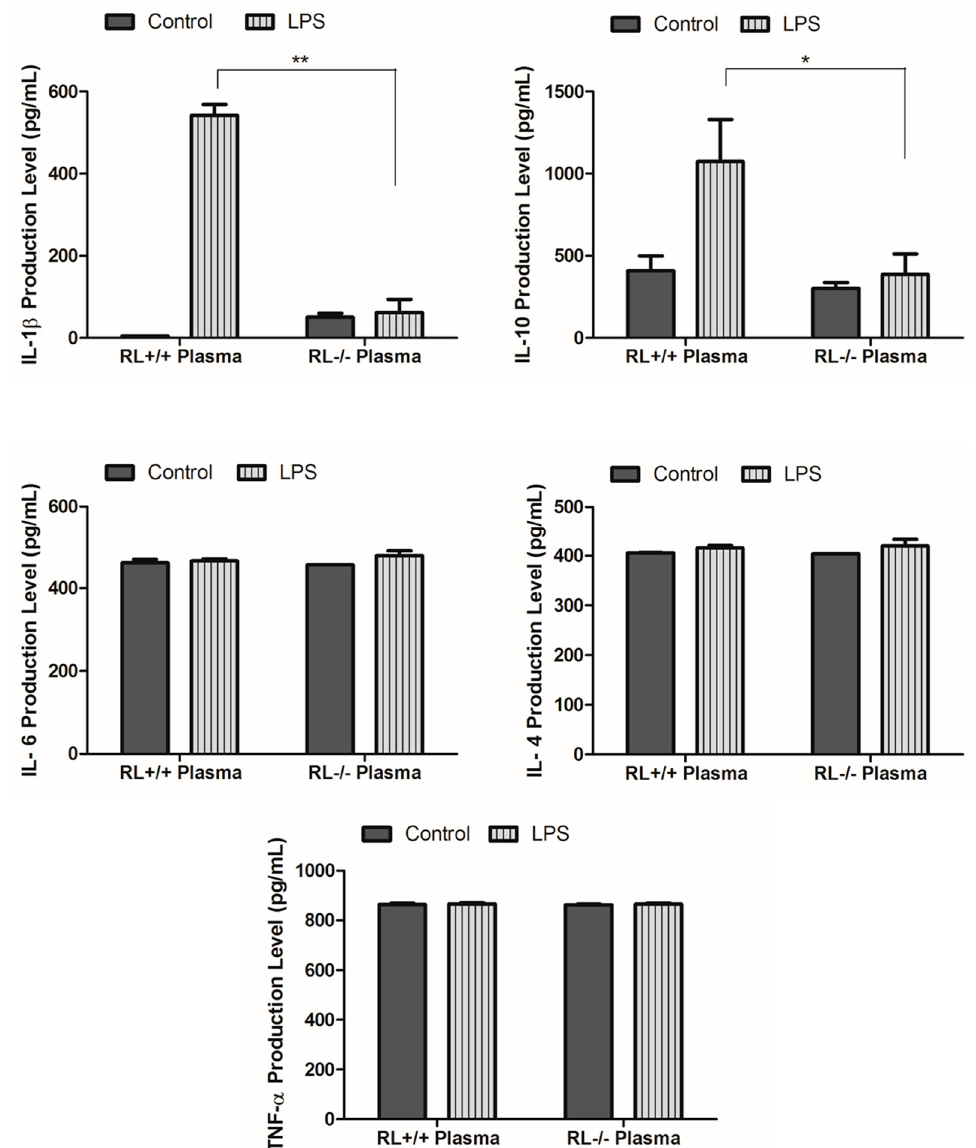
Figure 3. Levels of certain cytokines and chemokines in the plasma. Cornea blood was isolated from RNase L wild type and deficient mice that received intranasal instillation of LPS for 24 h. The level of certain cytokines and chemokines in the plasma was measured using an ELISA kit for each of the indicated markers. Experiments were performed twice in triplicates. Data are presented as mean ± SD. * p < 0.05, ** p < 0.001.